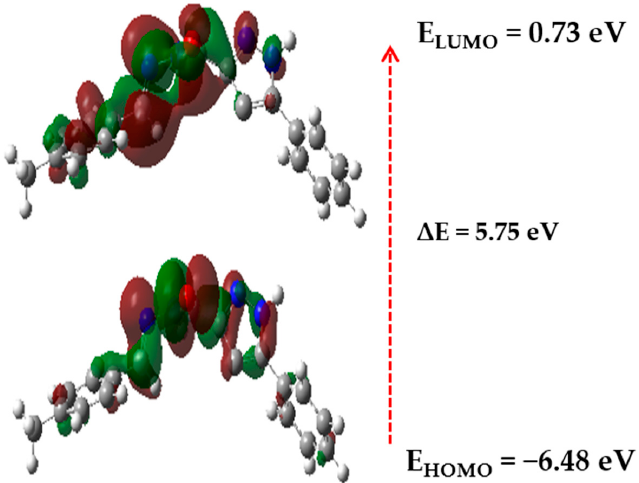
Figure 5. HOMO–LUMO energy diagram of L2 .